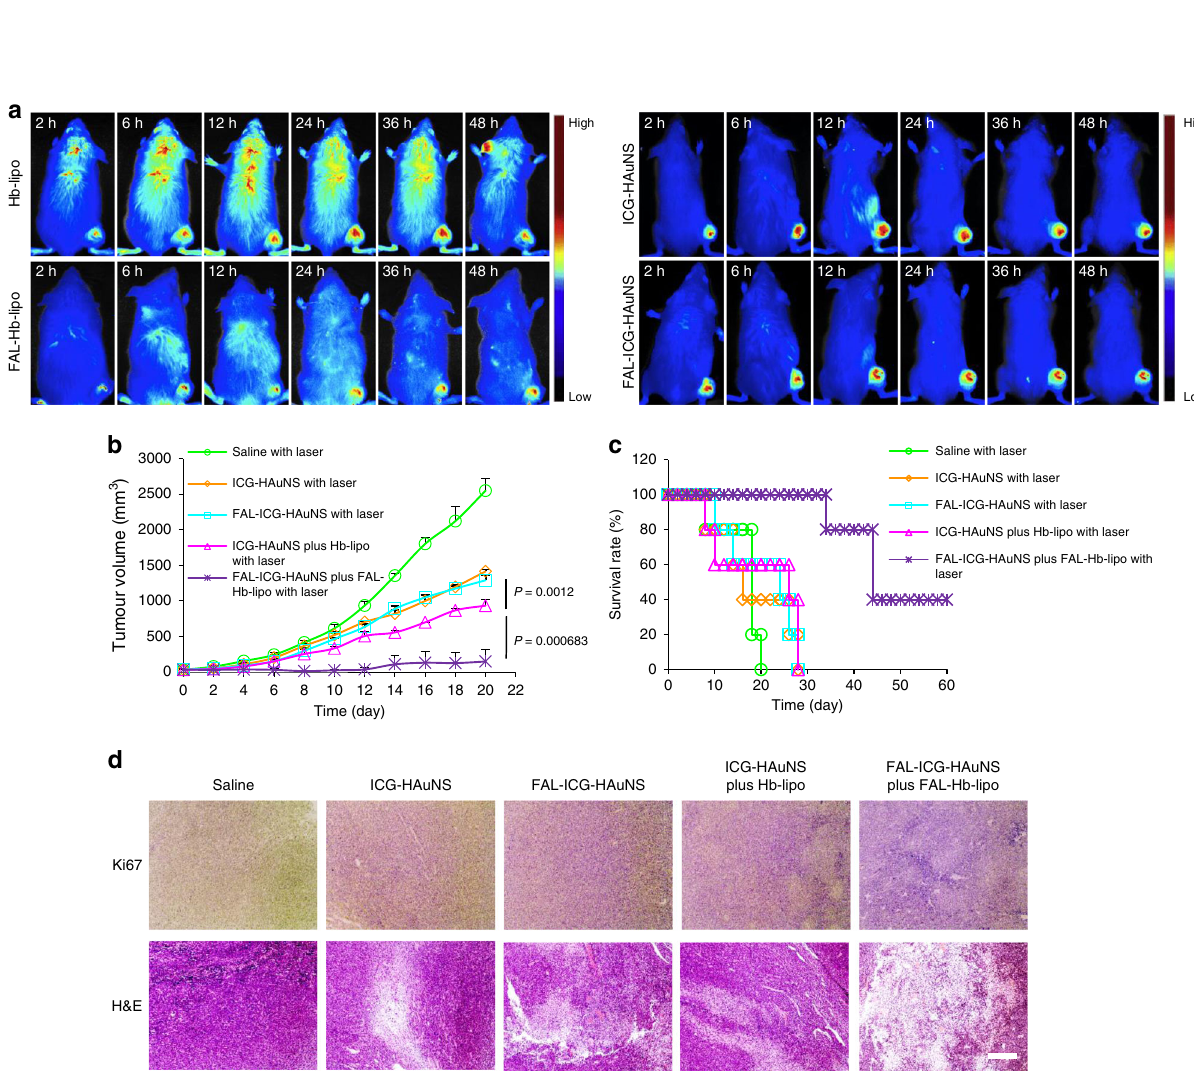
Fig. 5 Biodistribution and antitumor effect in CT-26 tumor model. a Real-time in vivo fl uorescent imaging in mice after they were intravenously injected with ICG-HAuNS (indocyanine green (ICG): 4 mg/kg; hollow gold nanospheres (HAuNS): 8 mg/kg), FAL-ICG-HAuNS (ICG: 4 mg/kg; HAuNS: 8 mg/kg), DiD@Hb-lipo (Hb: 20 mg/kg), or DiD@FAL-Hb-lipo (Hb: 20 mg/kg). Ex: 649 nm for DiD; 735 nm for ICG. b CT-26 tumor growth curves after treatment with saline, ICG-HAuNS (ICG: 0.5 mg/kg and HAuNS: 1 mg/kg per injection), FAL-ICG-HAuNS (ICG: 0.5 mg/kg and HAuNS: 1 mg/kg per injection), ICG- HAuNS (ICG: 0.5 mg/kg and HAuNS: 1 mg/kg per injection) plus Hb-lipo group (20 mg/kg per injection), or FAL-ICG-HAuNS (ICG: 0.5 mg/kg and HAuNS: 1 mg/kg per injection) plus FAL-Hb-lipo (20 mg/kg per injection). Laser power: 1 W/cm 2 , 2 min, n = 6. c Kaplan – Meier plots on animal survival, n = 6. d Representative Ki-67 and hematoxylin and eosin staining results in each group. Scale bars, 300 μ m. All data were analyzed with one-way analysis of variance test. All error bars are expressed as